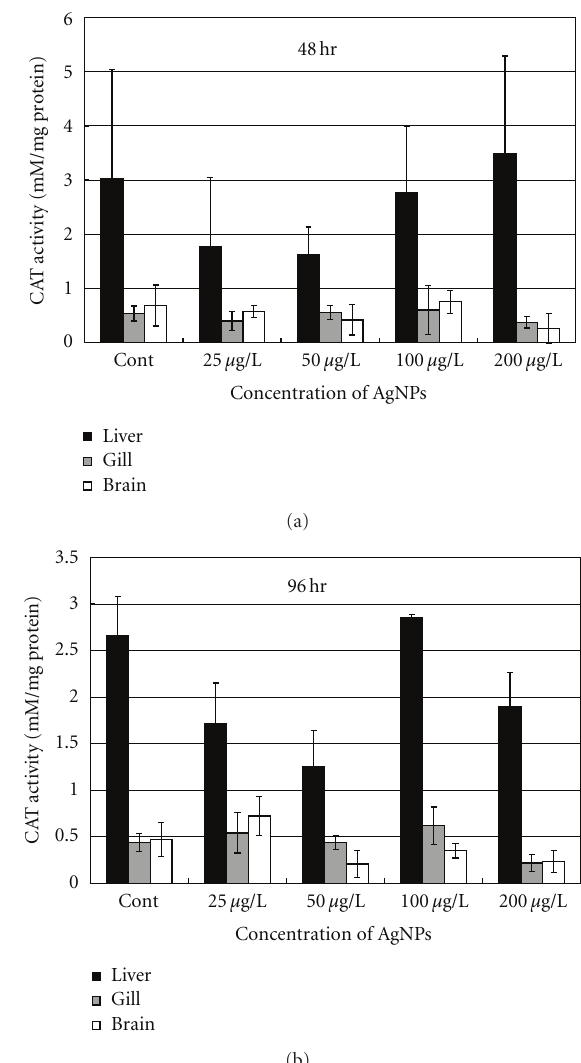
Figure 2: GST activity in di ff erent organs of the common carp exposed to various concentrations of Ag-NPs at (a) 48 h and (b) 96h.